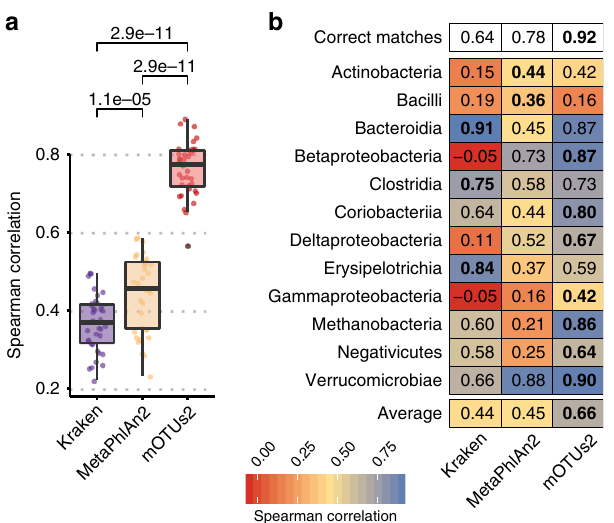
Fig. 4 Metatranscriptomic abundance pro fi ling with mOTUs2. a Spearman correlation between matched metagenomic and metatranscriptomic pro fi les obtained from 36 faecal samples with Kraken, MetaPhlAn2 and mOTUs2. mOTUs2 pro fi les (red) show signi fi cantly higher correlation than the other two methods (paired two-sided Wilcoxon test, boxplots show the median correlation as horizontal lines and interquartile ranges as boxes, whiskers extend at most 1.5 times the interquartile range). b The top-row represents the proportion of cases in which the distance (log-Euclidean) between metagenomic and metatranscriptomic pro fi les was smallest for the same sample. Below is a taxonomic breakdown (12 most abundant classes) of correlations between metagenomic and metatranscriptomic pro fi les. For each class, the highest correlation value across the tested methods are shown in bold. Source data are provided as a Source Data fi le.